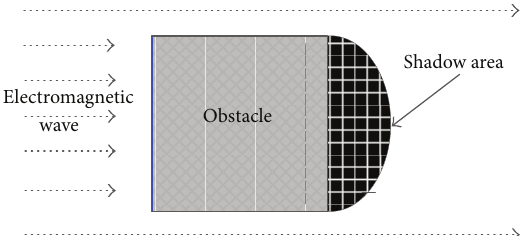
Figure 1: The obstacle blocks the electromagnetic waves and forms the shadow